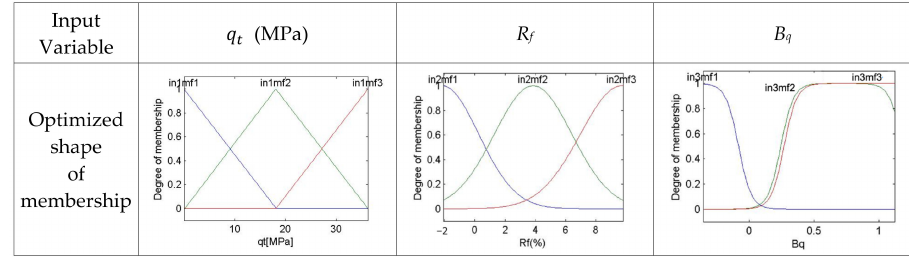
Figure 8. Optimized Shapes of fuzzy membership functions after training.